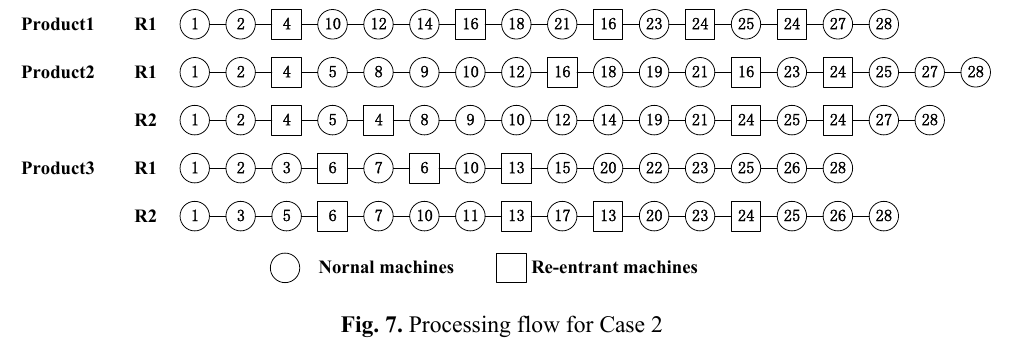
Fig. 6. The output of the solution space for Case 1 after ordinal transformation